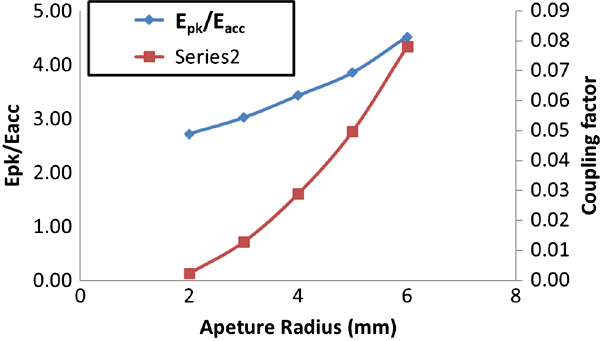
FIG. 2. Ratio of peak electric field to accelerating field and coupling coefficient as a function of aperture radii for a β ¼ 0 . 7